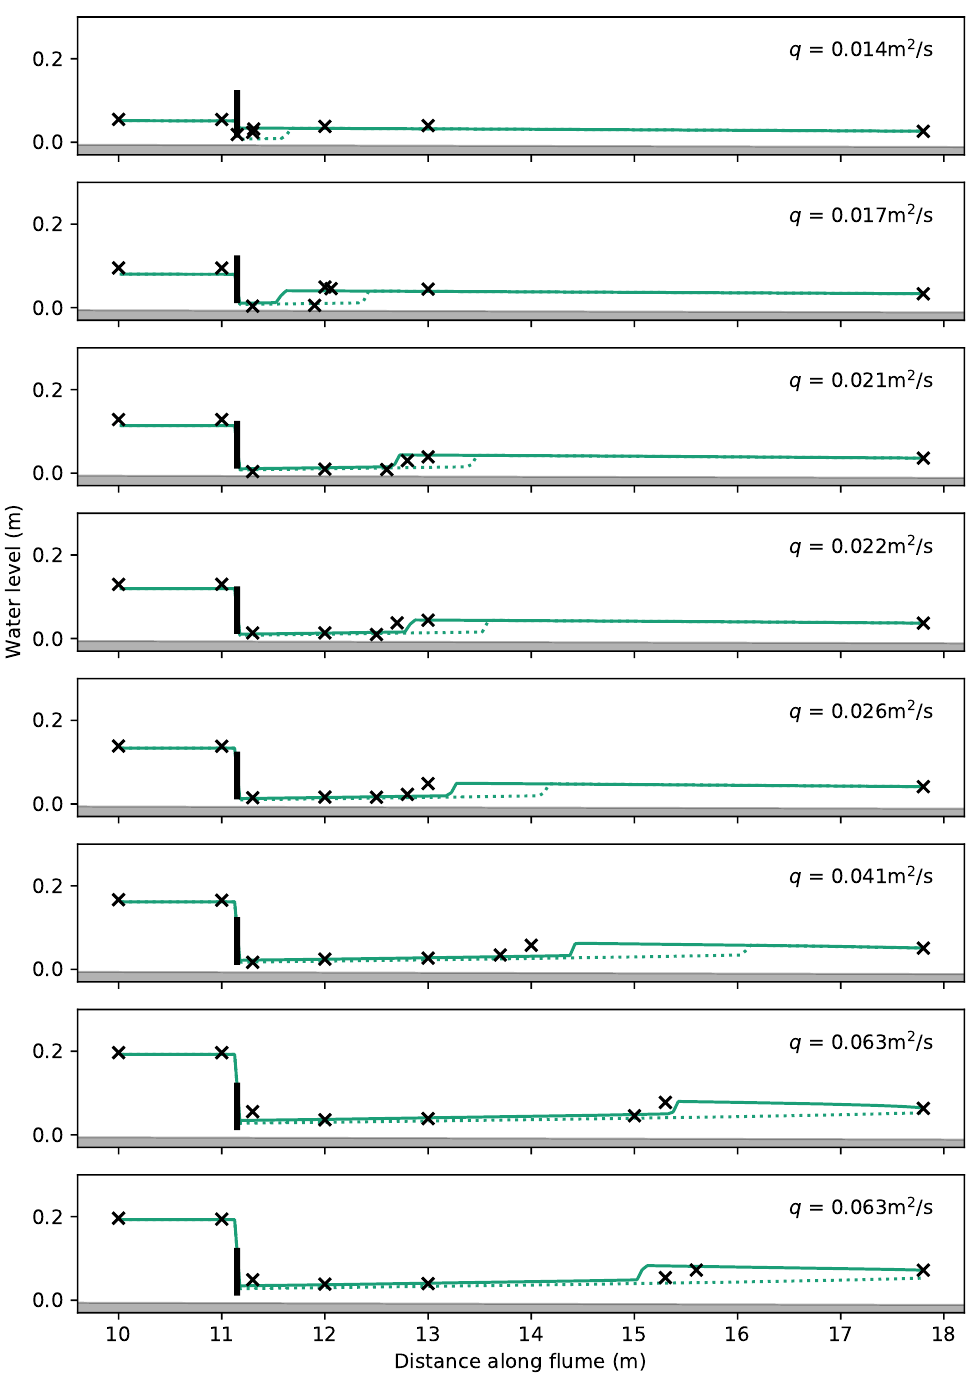
Figure A5. Results for configuration